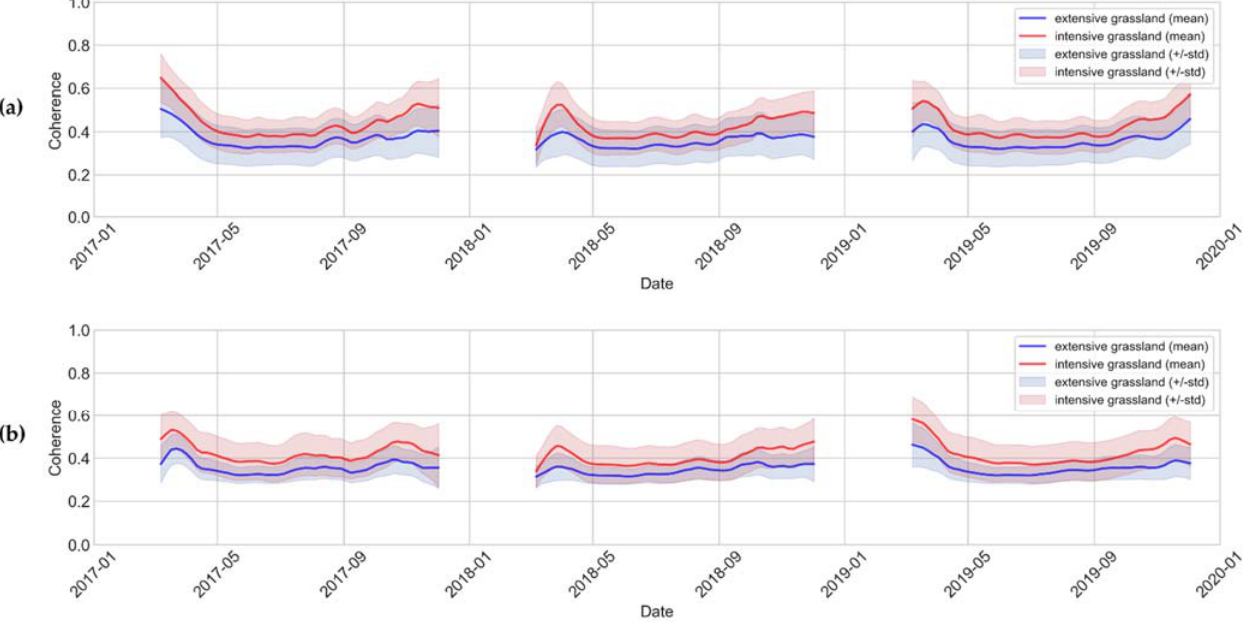
Figure 4. Mean temporal profiles and standard deviation range (+/ − std) of coherence ascending ( a ) and coherence descending ( b ) time series on intensive (red) and extensive (blue) grassland.